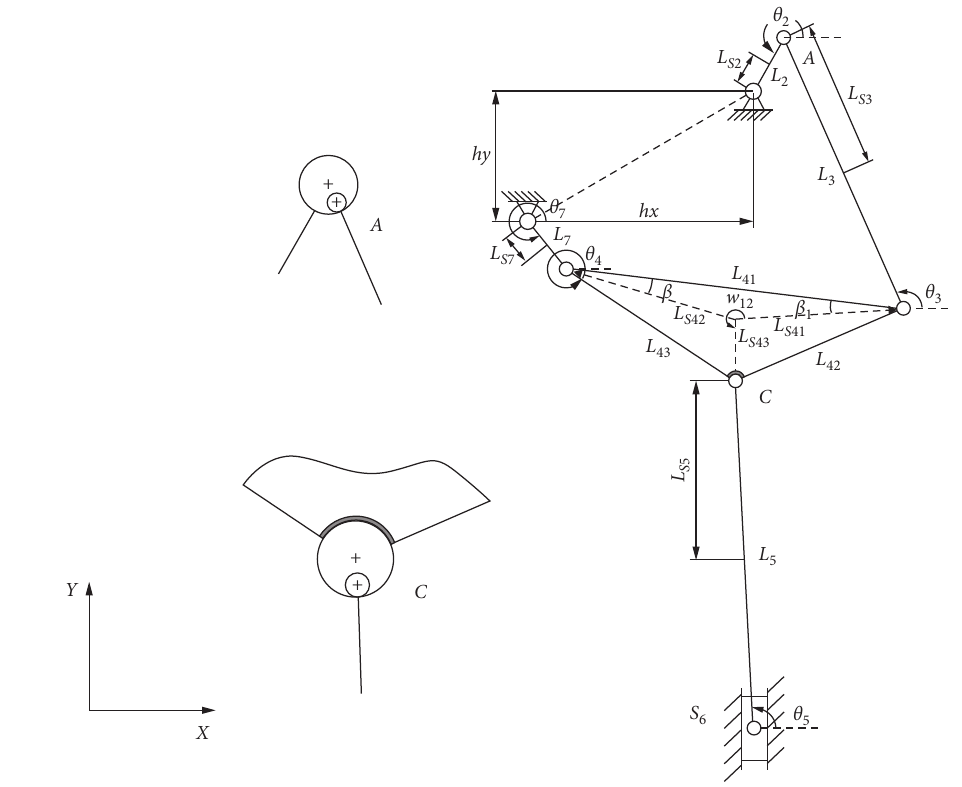
Figure 2: Hybrid driven seven-bar mechanism. Table 1: Design parameters of the hybrid driven seven-bar mechanism.